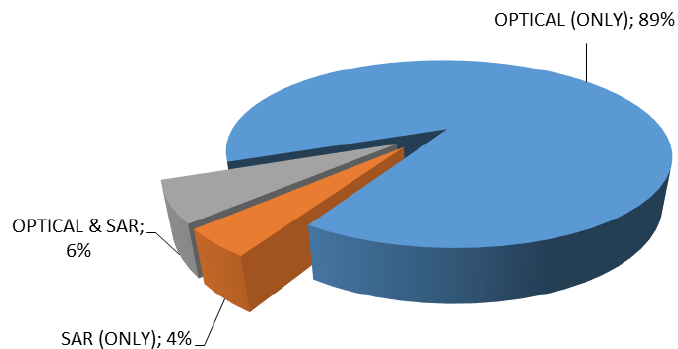
Figure 5. Distribution of peer-reviewed publications by type of satellite images used for looting assessment, either optical, synthetic aperture radar (SAR) or a combination of both. Publication database updated as of June 2019.